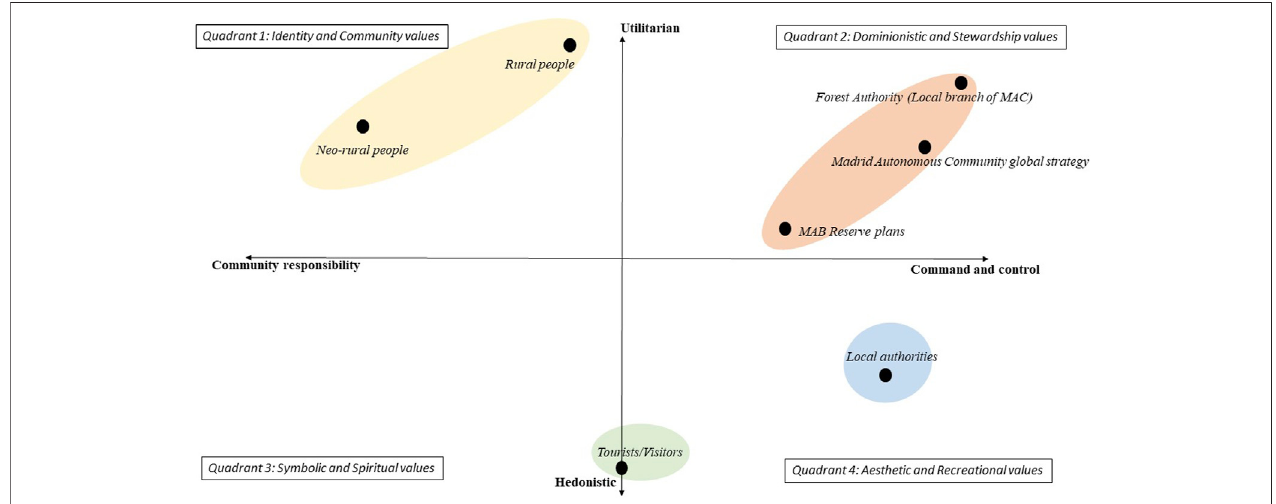
FIGURE4| GraphicrepresentationofvaluesdevelopedbydifferentstakeholdersintheCHANSofLaPuebladelaSierra.Eachquadrantralliedseveralrelationalvalues in categories as 1) Identity and Community values; 2) Dominionistic and Stewardship values; 3) Symbolic and Spiritual values; and 4) Aesthetic and Recreational values.